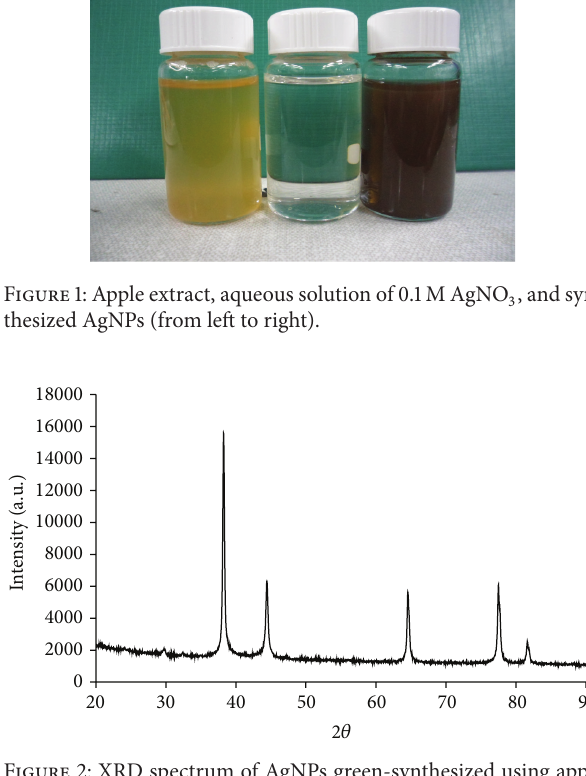
Figure 2: XRD spectrum of AgNPs green-synthesized using apple